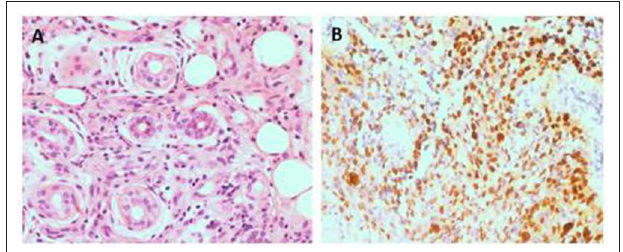
FIGURE 1 | Pathological analysis of skin ulcer shows a perivascular lymphocytic infiltrate and fibrinoid necrosis of small vascular wall(HE 400x) (A) . The lymphoma cells are positive for EBER(400x) (B)